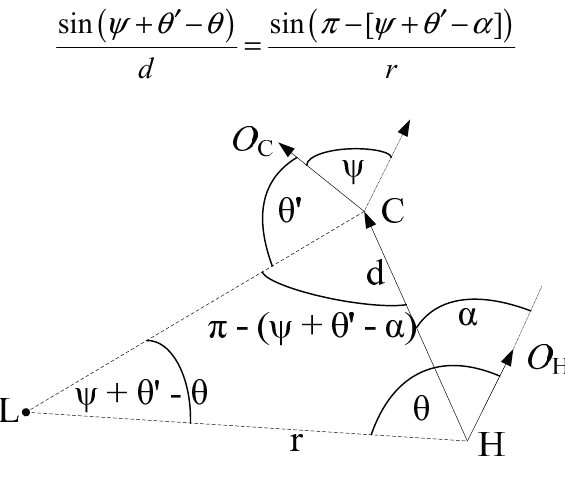
Figure 1. Derivation of the proposed homing